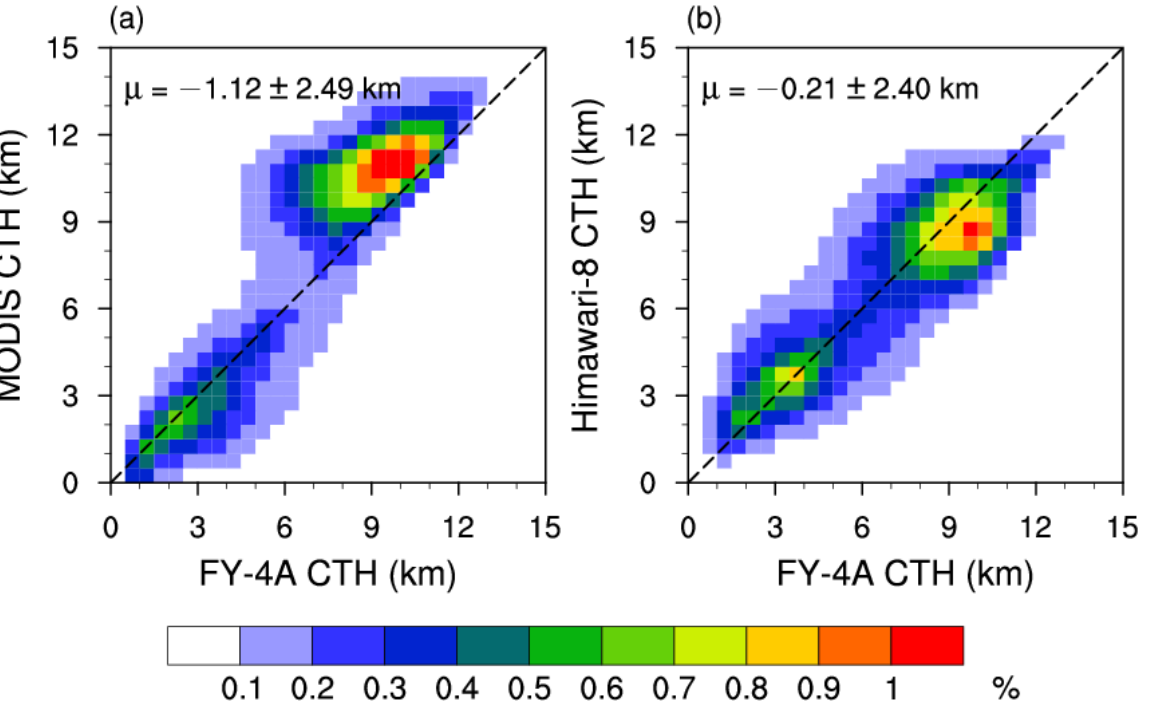
Figure 3. Pixel-to-pixel comparison of FY-4A CTH with ( a ) MODIS CTH and ( b ) Himawari-8 CTH. The timespan used for the statistics is from 2 to 9 September 2020, in which Himawari-8 only has daytime data. The color fill is the occurrence probability of each bin, and the bin interval is 0.5 km.